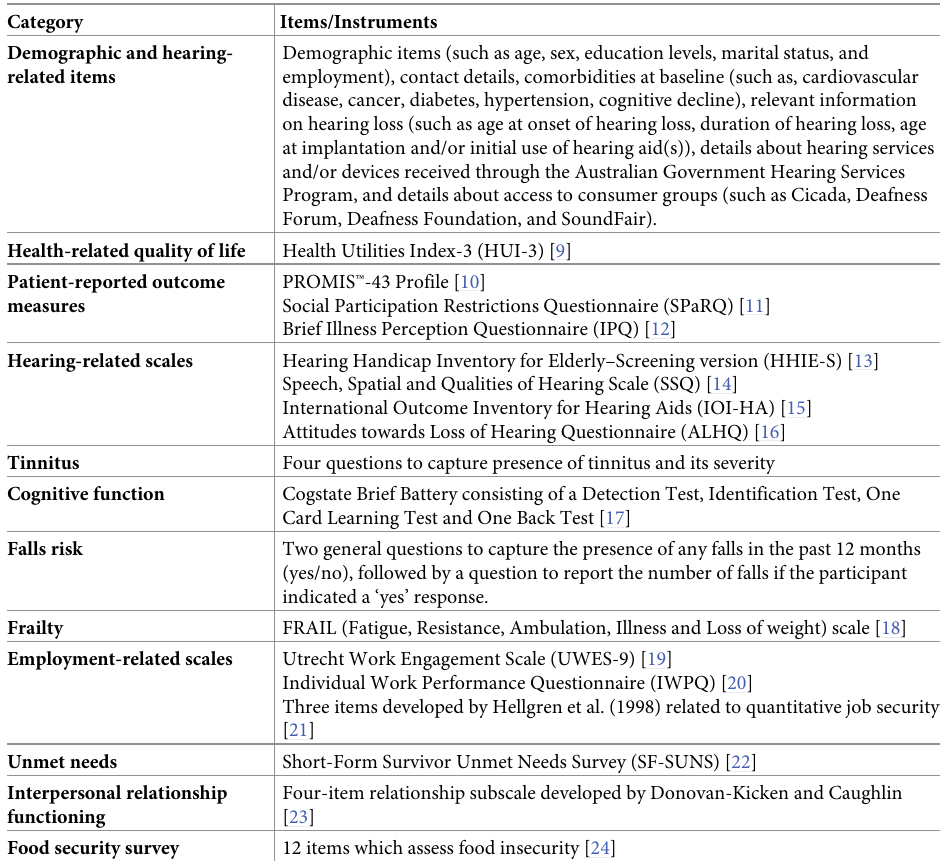
Table 1. Outcome measures in